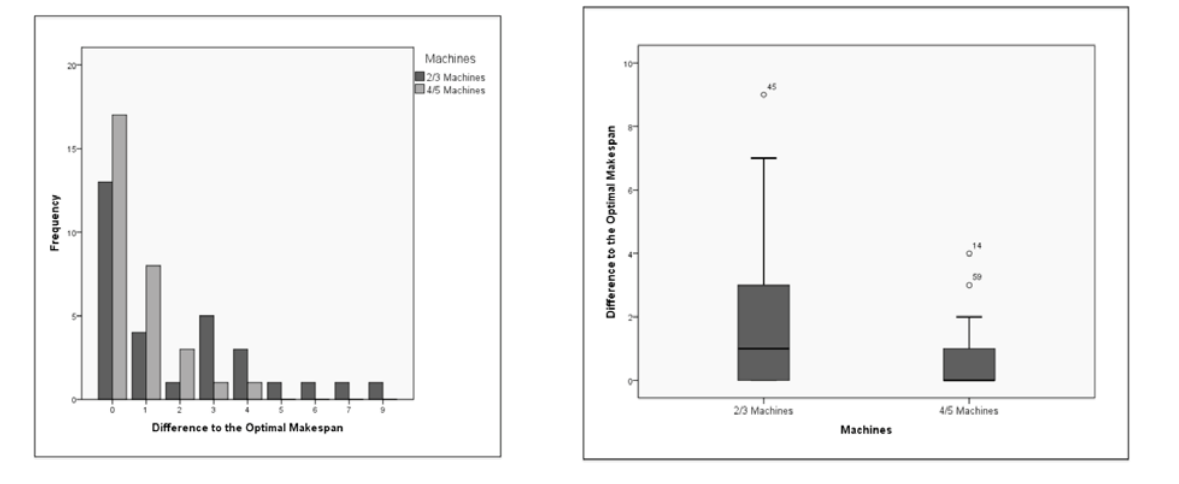
Fig. 9. Boxplot of the solutions for 2/3 and 4/5